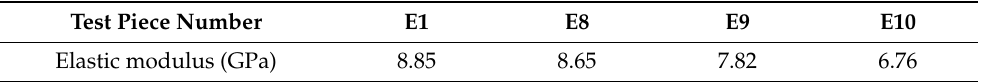
Table 3. Elastic modulus of limestone samples with di ff erent water content rates.